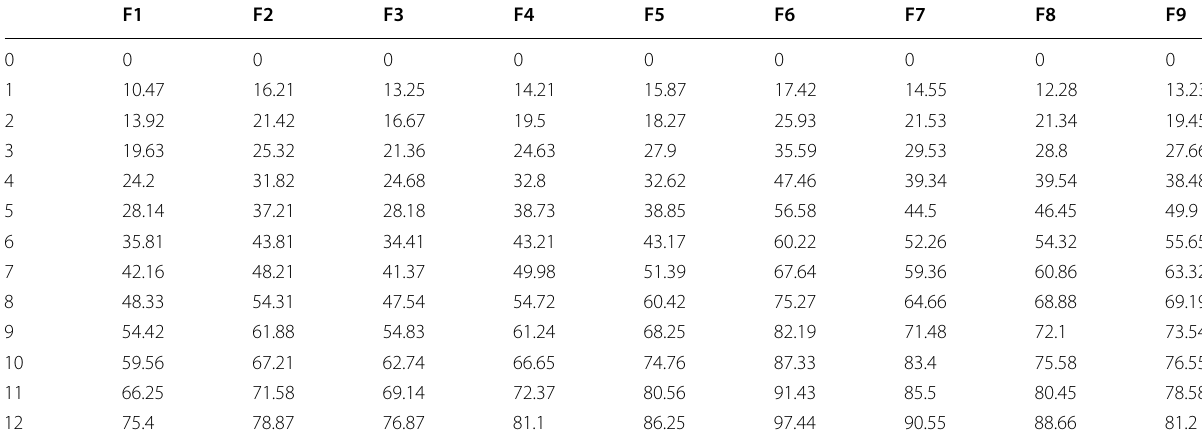
*Values are indicated as percent (%) cumulative drug release